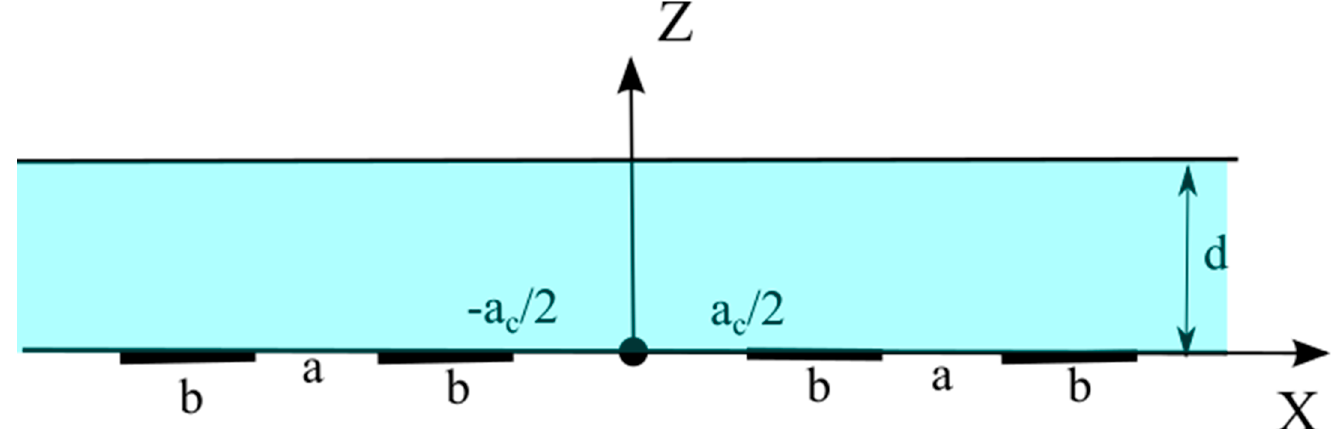
Figure 2. Schematic of the planar electrochemical cell used for stationary concentration calculation.